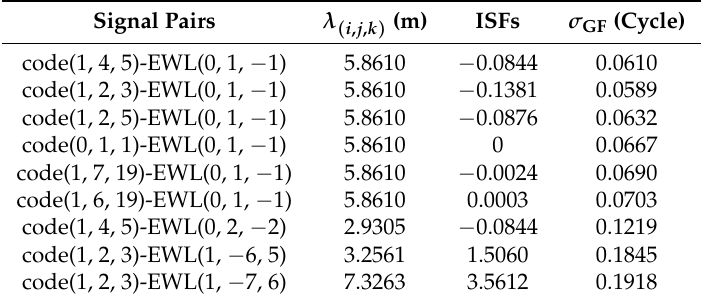
Table 1. The wavelength, ISFs and the measurement noise of the EWL signals working with combined code signals in GF TCAR.